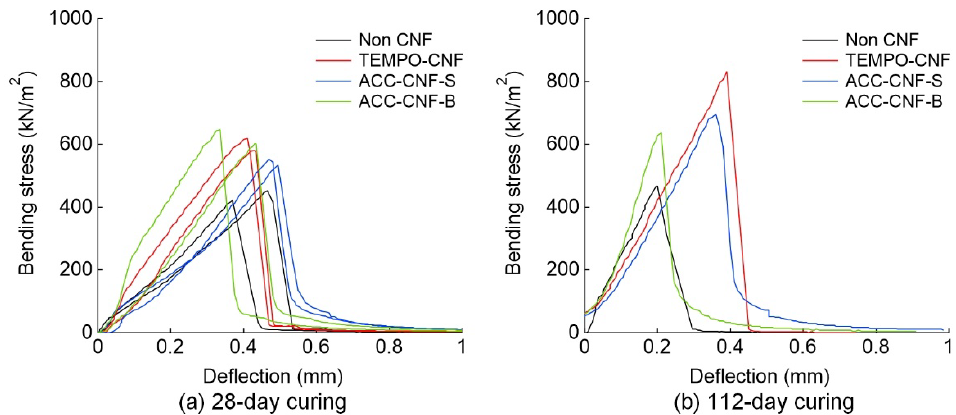
Figure 8. Relation between bending stress and deflection in bending strength tests (Method 1).